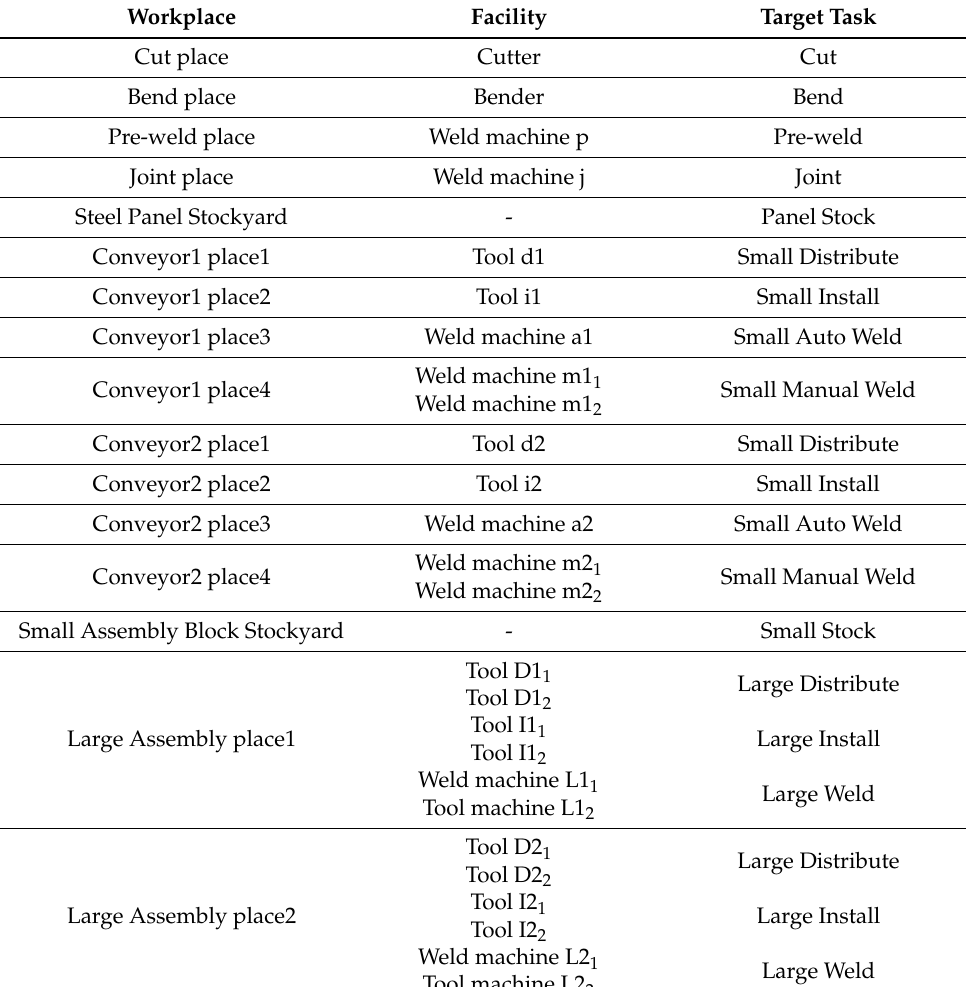
Table 2. Workplaces Data in Case